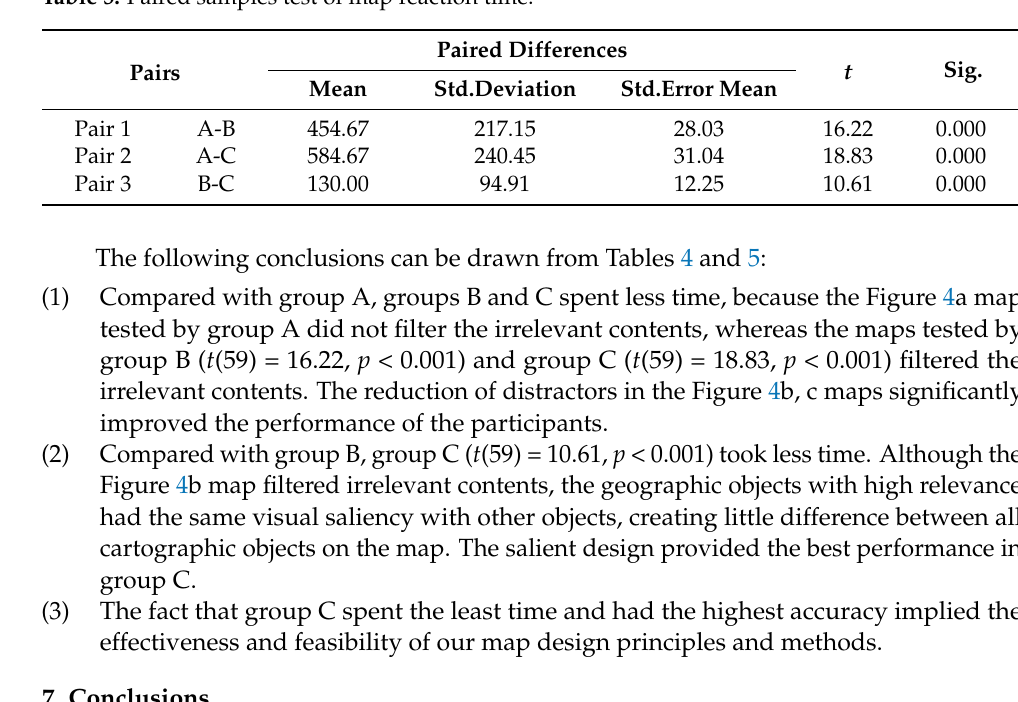
Table 5. Paired samples test of map reaction